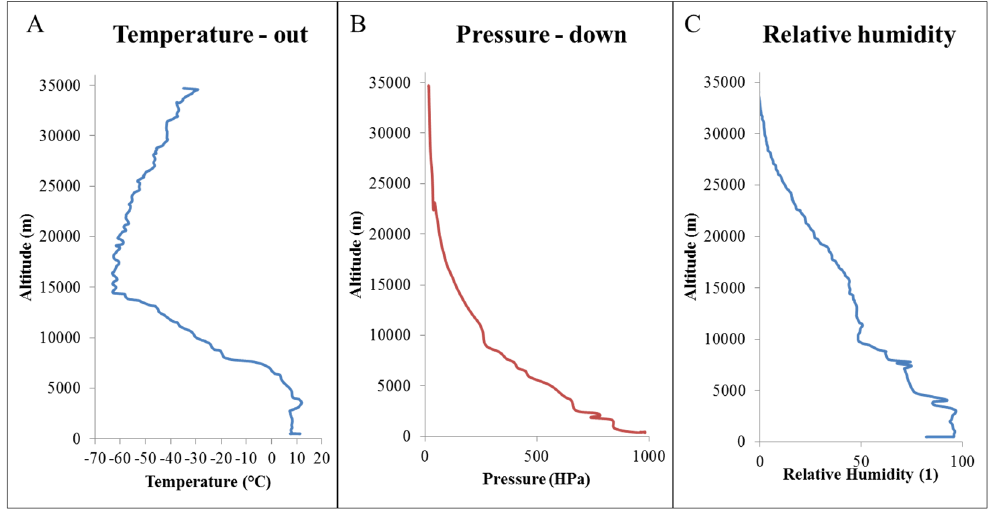
Figure 1. Conditions observed during the flight of the stratospheric probe in the stratosphere: ( A ) temperature outside the stratospheric probe, ( B ) stratospheric pressure and ( C ) relative